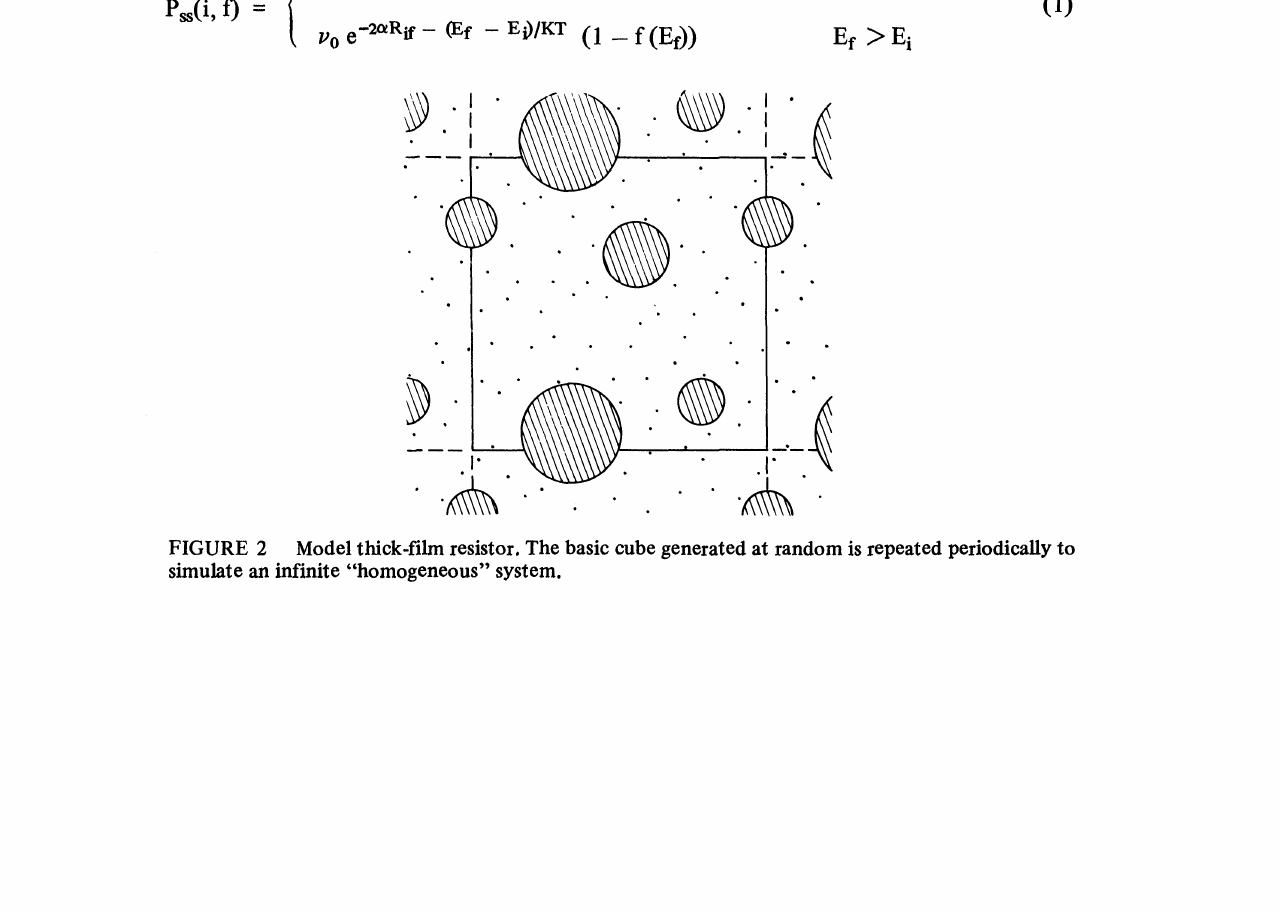
FIGURE Conductivity of two thick-film resistors as a function of temperature. Ruthenium- pyrochlore-based resistor; IrO -based resistor.